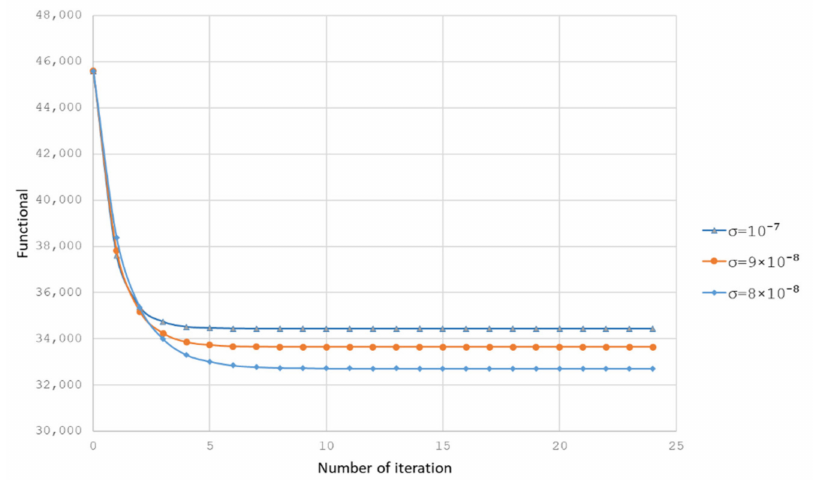
Figure 2. Dependence of the target functional on the iteration